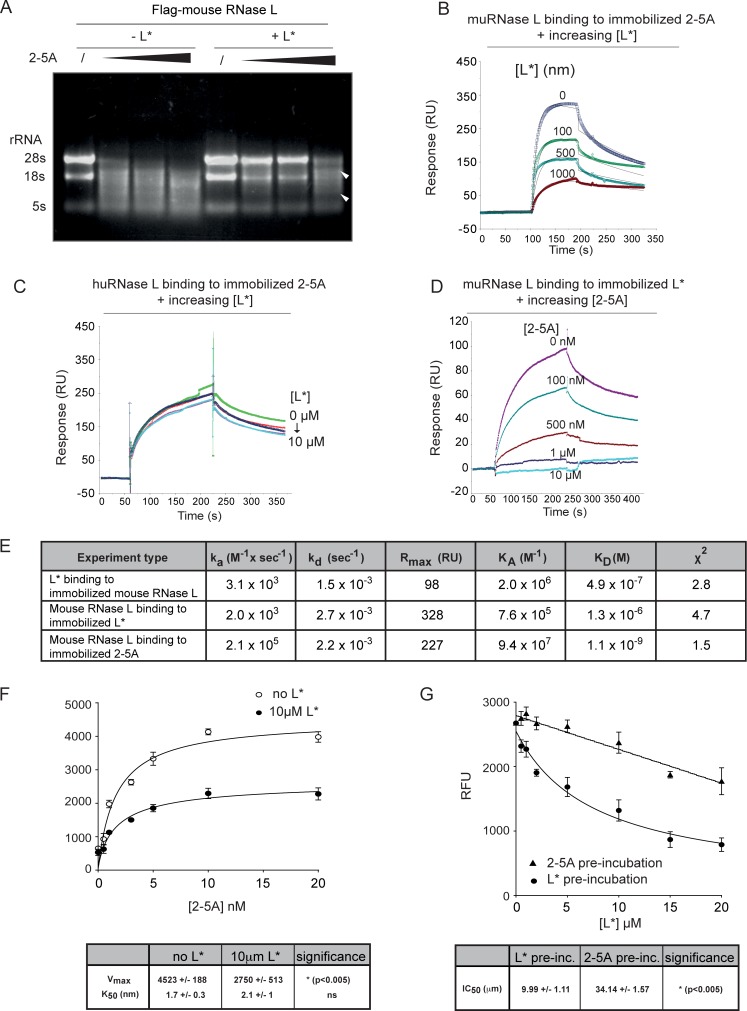
L* interferes with 2-5A binding to mouse RNase L.A. Lysates of 293T cells overexpressing Flag-RNase L and L* were treated with increasing concentrations of 2-5A (0, 2, 4 and 8 μM ATP equivalent of 2-5A) before incubation, RNA extraction and analysis on agarose gel. Arrowheads indicate RNase L-generated rRNA degradation products upon treatment with high concentration of 2-5A, arising despite the presence of L*. B-C. Biotin-labeled 2-5A was immobilized on streptavidin-coated SPR gold chips. (B) Mouse (mu)RNase L (2.5 μM) or (C) human (hu)RNase L (2.5 μM) were injected in the absence or presence of different concentrations of L* as indicated. D. His6-L* binding was immobilized on Ni-NTA chips and mouse RNase L (2.5 μM) was injected in the absence or presence of different concentrations of 2-5A as indicated. RU, response units. E. Kinetic parameters of interactions between mouse RNase L and L* or 2-5A. F-G. Histograms showing mean relative fluorescence units (RFU) resulting from degradation of a FRET RNA probe by RNase L. Experiments were repeated twice in triplicates. F. Mouse RNase L (100 nM) was pre-incubated with mock (circle) or 10μM (triangle) of L* followed by addition of varying concentration of 2-5A p3A3. Graph showing the mean and SEM of RNase L activity and table showing inferred Vmax (maximum velocity), K50 (concentration for half activation) and statistical significance of the differences between the two conditions (unpaired t-test). Ns: non-significant G. Mouse RNase L was either pre-incubated with varying concentration of L* (circle) followed by addition of 3nM of 2-5A or pre-incubated with 3 nM 2-5A followed by addition of varying concentration of L* (triangle). Graph showing mean and SEM of RNase L activity and table showing inferred IC50 (half maximal inhibitory concentration) and statistical significance of the difference between the two conditions (unpaired t-test).